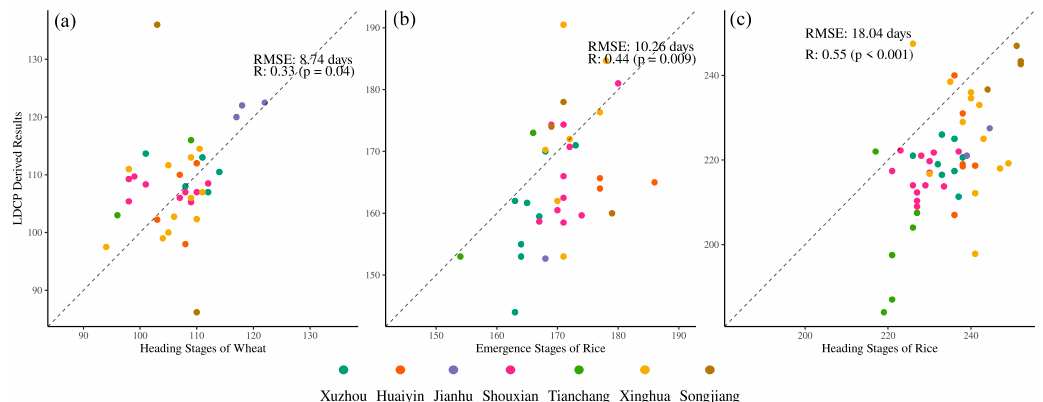
Figure 3. Validation of LDCP-derived phenological metrics (POS1 for ( a ), SOS2 for ( b ), POS2 for ( c )) in relation to the in situ phenological stages. Dashed black line is the 1:1 line. Colored points represent results at 7 ground cropland phenology stations. RMSE stands for root mean square error. R represents the correlation between crop stages on the ground and predicted phenological metrics from remote sensing.